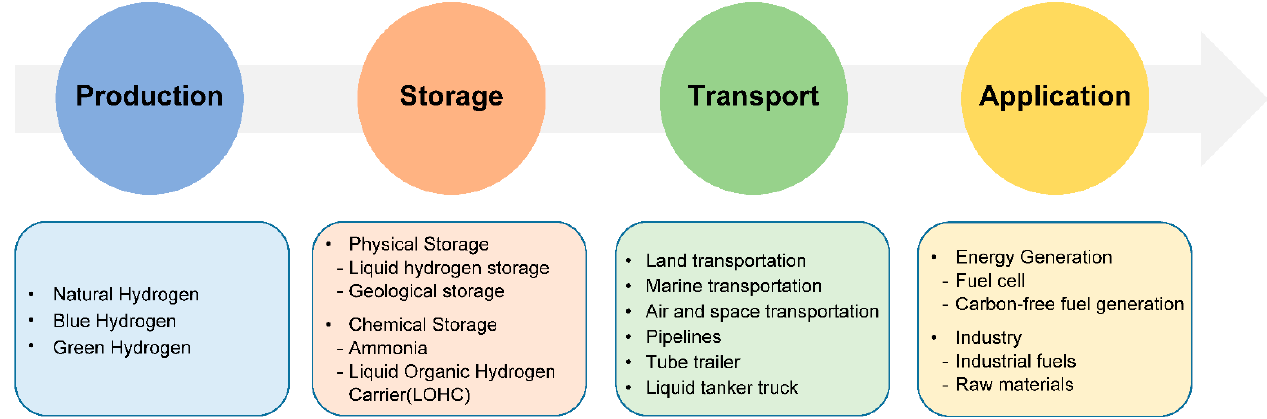
Figure 3. Specific technologies by hydrogen vale